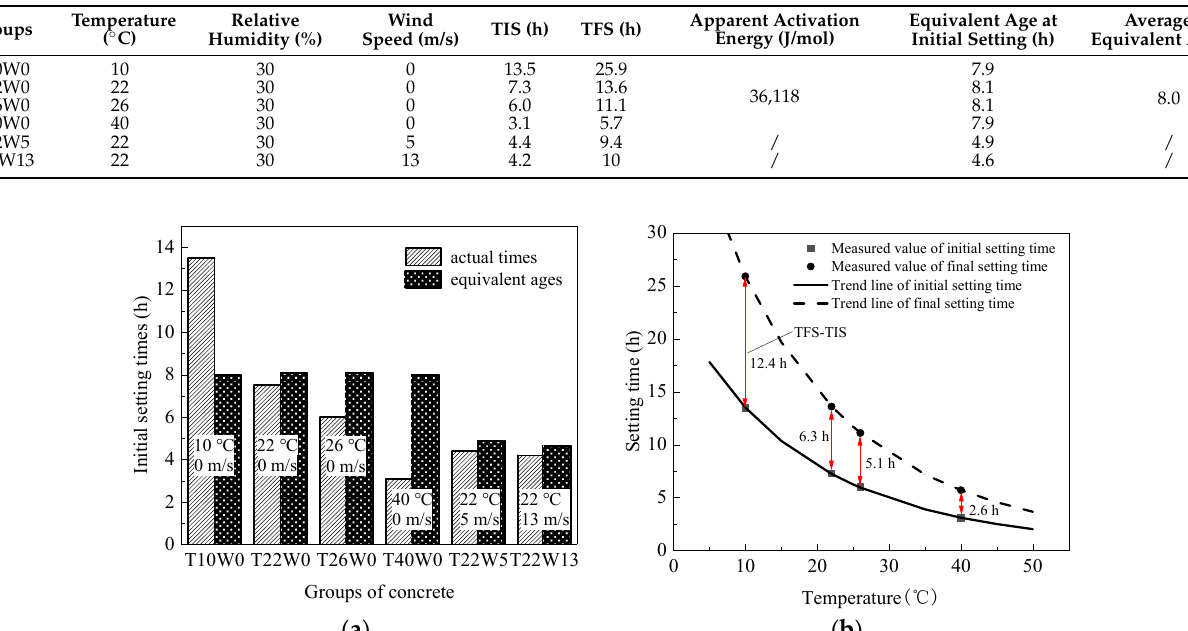
Figure 5. ( a ) Initial setting times and equivalent ages, ( b ) Variation curve of initial and final setting time of concrete at different temperatures.